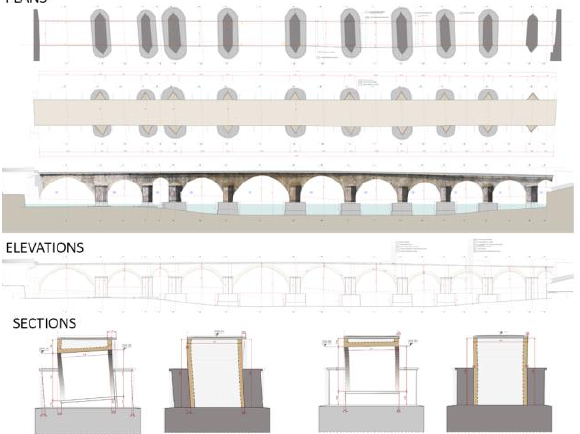
Figure 5. Azzone Visconti bridge's 2D CAD drawings from HBIM